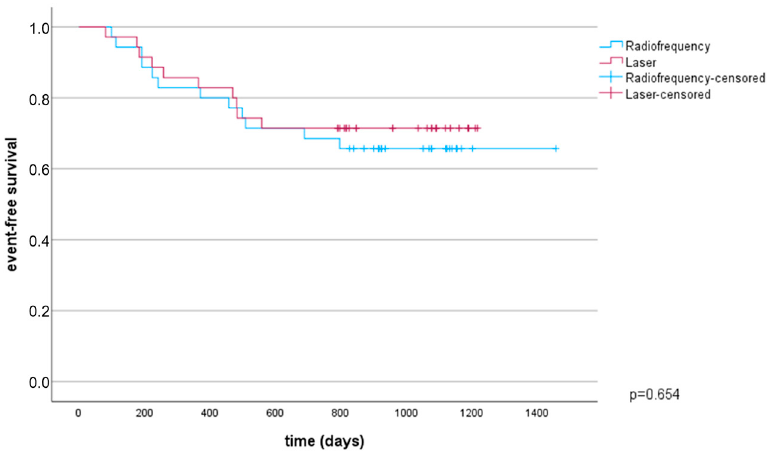
Figure 3. Kaplan-Meier analysis of event-free survival